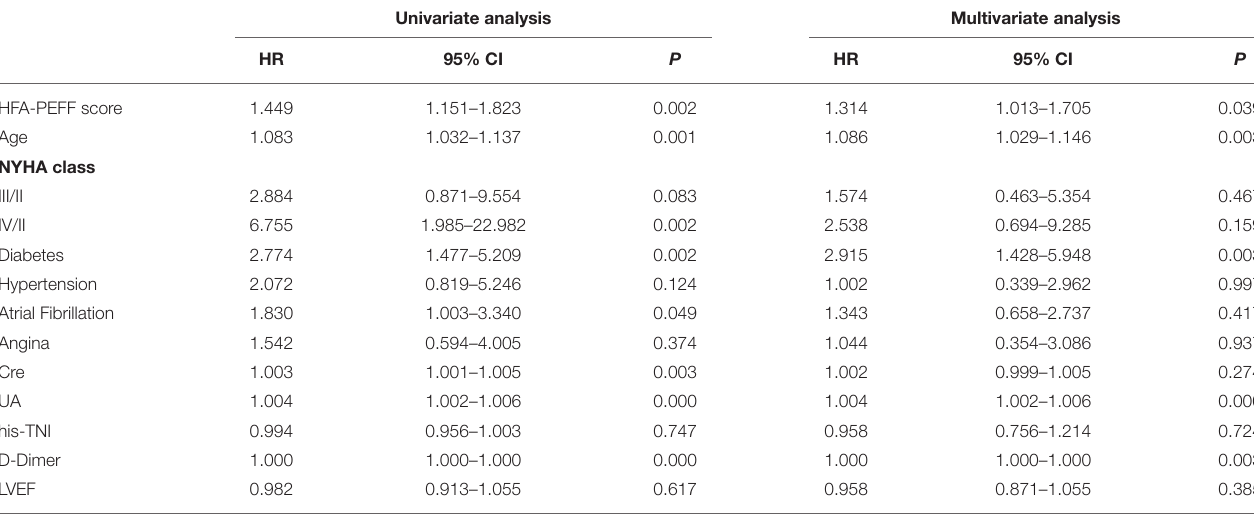
TABLE 3 | Risk factors of all-cause death in heart failure with preserved ejection fraction (HFpEF). Univariate